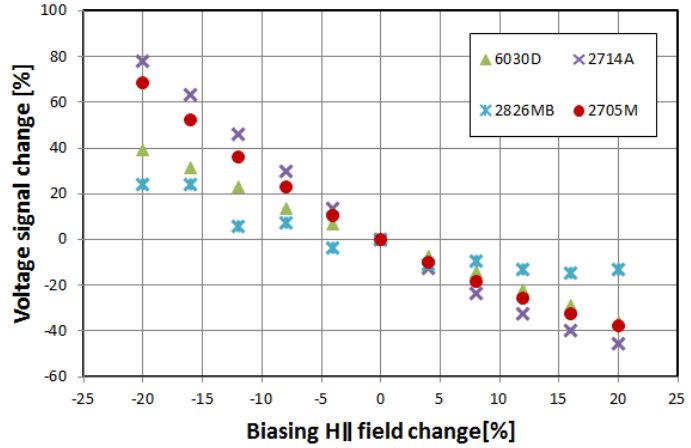
Figure 6. Relative change of the induced e 2f voltage in the function of biasing H ∥ field change.